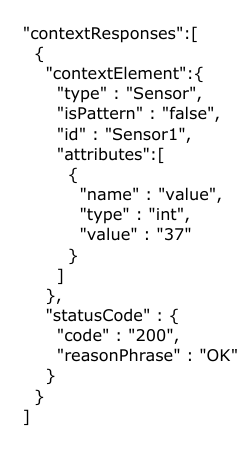
Figure 9. Orion sensor information after receiving data from IoT agent.